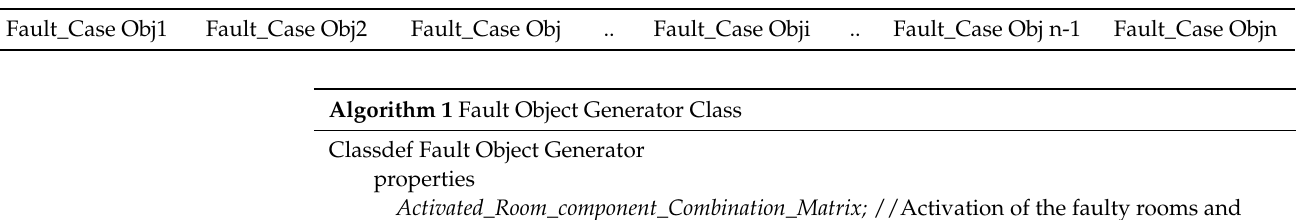
Table 5. FIV consists of fault-case